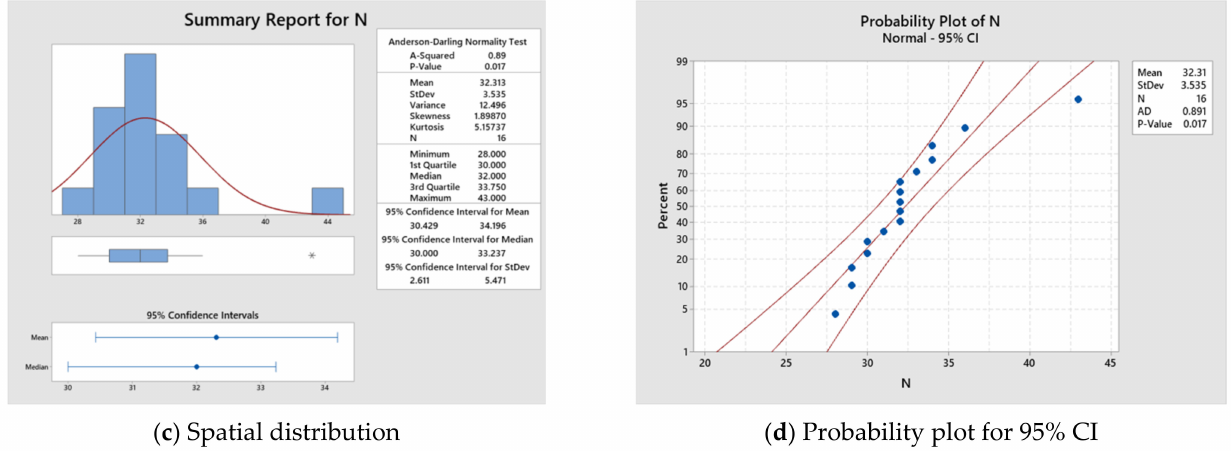
Figure 4. Statistical analyses of the results of the MFO algorithm.